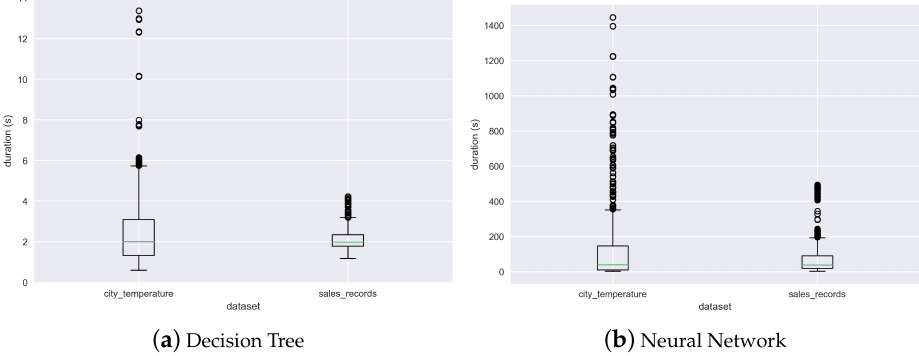
Figure 3. Distributionofthetrainingtimebydatasetforbothalgorithms: